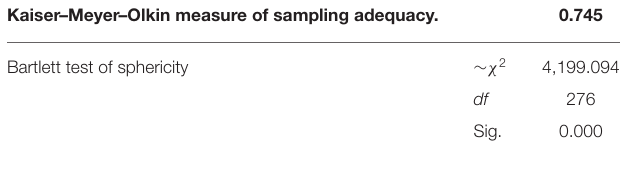
TABLE 2 | KMO and Bartlett test.